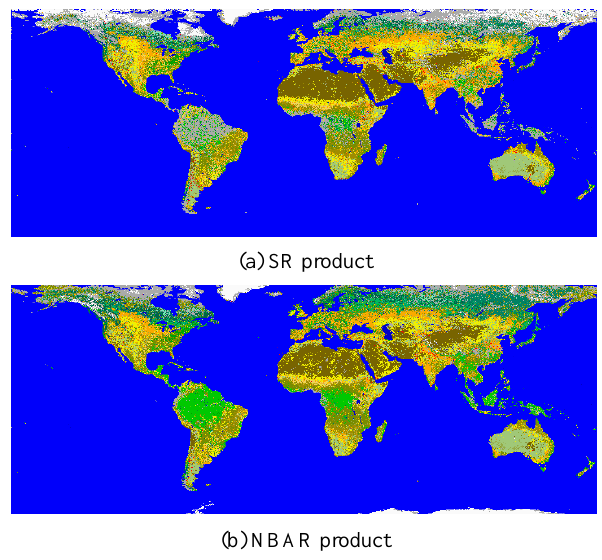
Figure 10. Land cover classification